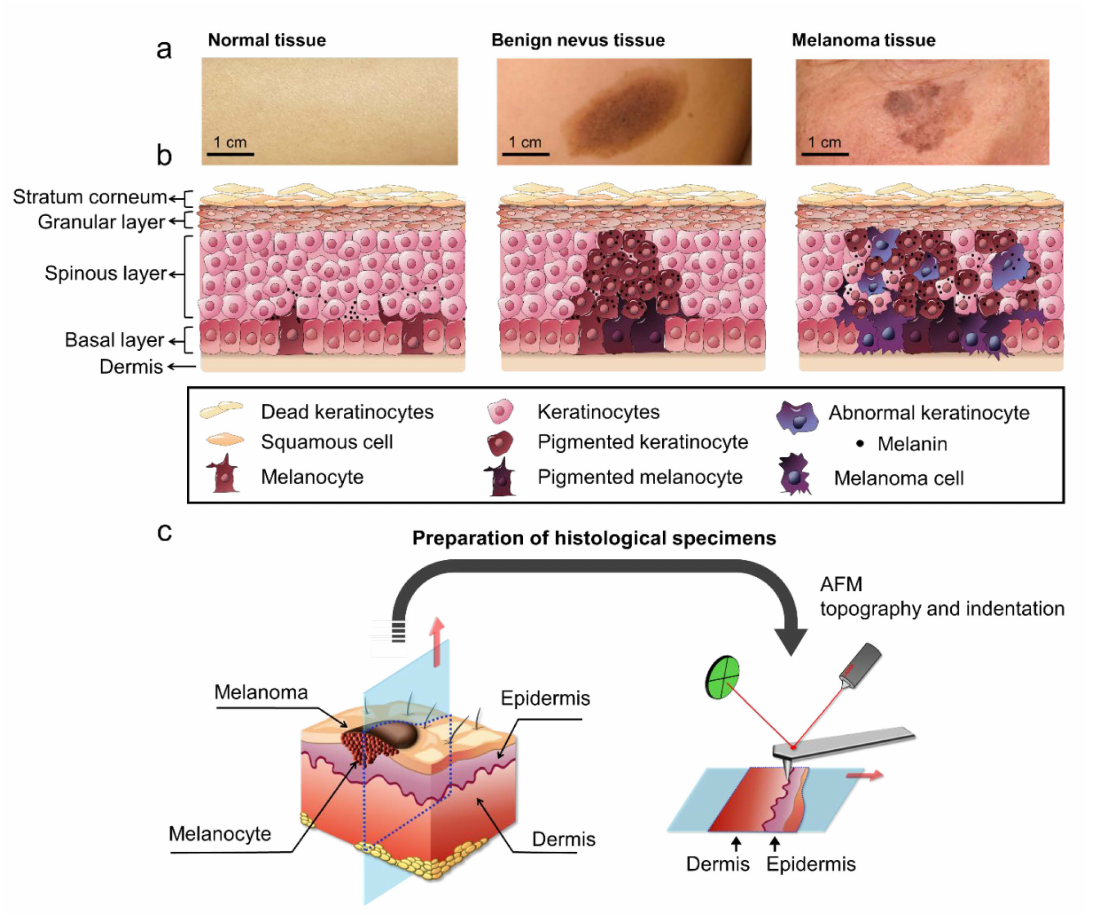
Figure 1. The morphological spectrum and AFM-based analysis of histological specimens. ( a ) Clinical images of the outermost layer of skin (left to right: normal, benign nevus, melanoma). ( b ) Schematic illustration of anatomical structures for each type of skin tissue and a rationale of malignant melanoma development with melanin transfer and pigmentation processes in the vicinity of a basal layer. ( c ) Schematic illustration of tissue biopsy (sampling) and AFM-based